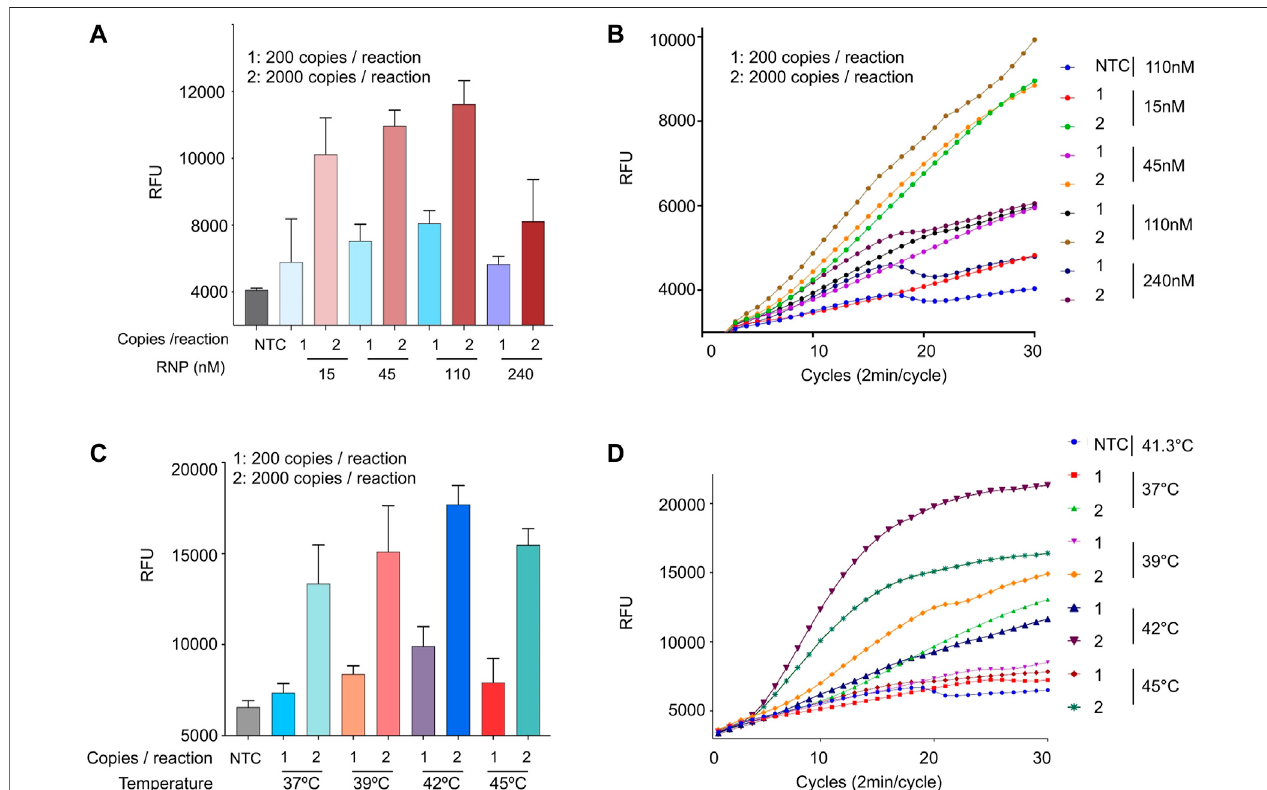
FIGURE 5 | Optimization of RNP concentration and temperature conditions. (A) The effect of the RNP complex concentration on the iSCAN-V2 assay. The assay was performed with 15, 45, 110, and 240 nM of RNP. SARS-CoV-2 RNA at 800 copies/µl with 110 nM of RNP was used as a positive control. (B) Real-time representation of iSCAN-V2 assays performed with different concentrations of RNP as shown in (A) . (C) The effect of temperature on the iSCAN-V2 assay. The assay was performed using a temperature gradient (37, 39, 41.3, and 45 ° C). For the positive control, the assay was performed with 800 copies of SARS-CoV-2 RNA/µL at 41.3 ° C. (D) Real-time representation of iSCAN-V2 assays performed at different temperatures as shown in (C) . CFX96 (Bio-Rad) end-point fl uorescence readouts were converted to graphical format using GraphPad Prism. For end-point fl uorescence data presentation, error bars (cid:1) means ± SD ( n (cid:1) 3). Forreal-time representation, the intensity of the fl uorescent signal was measured every 2 min for a period of 1 hour. Values shown in the graphs are means of 3 independent readings. NTC, no template control.